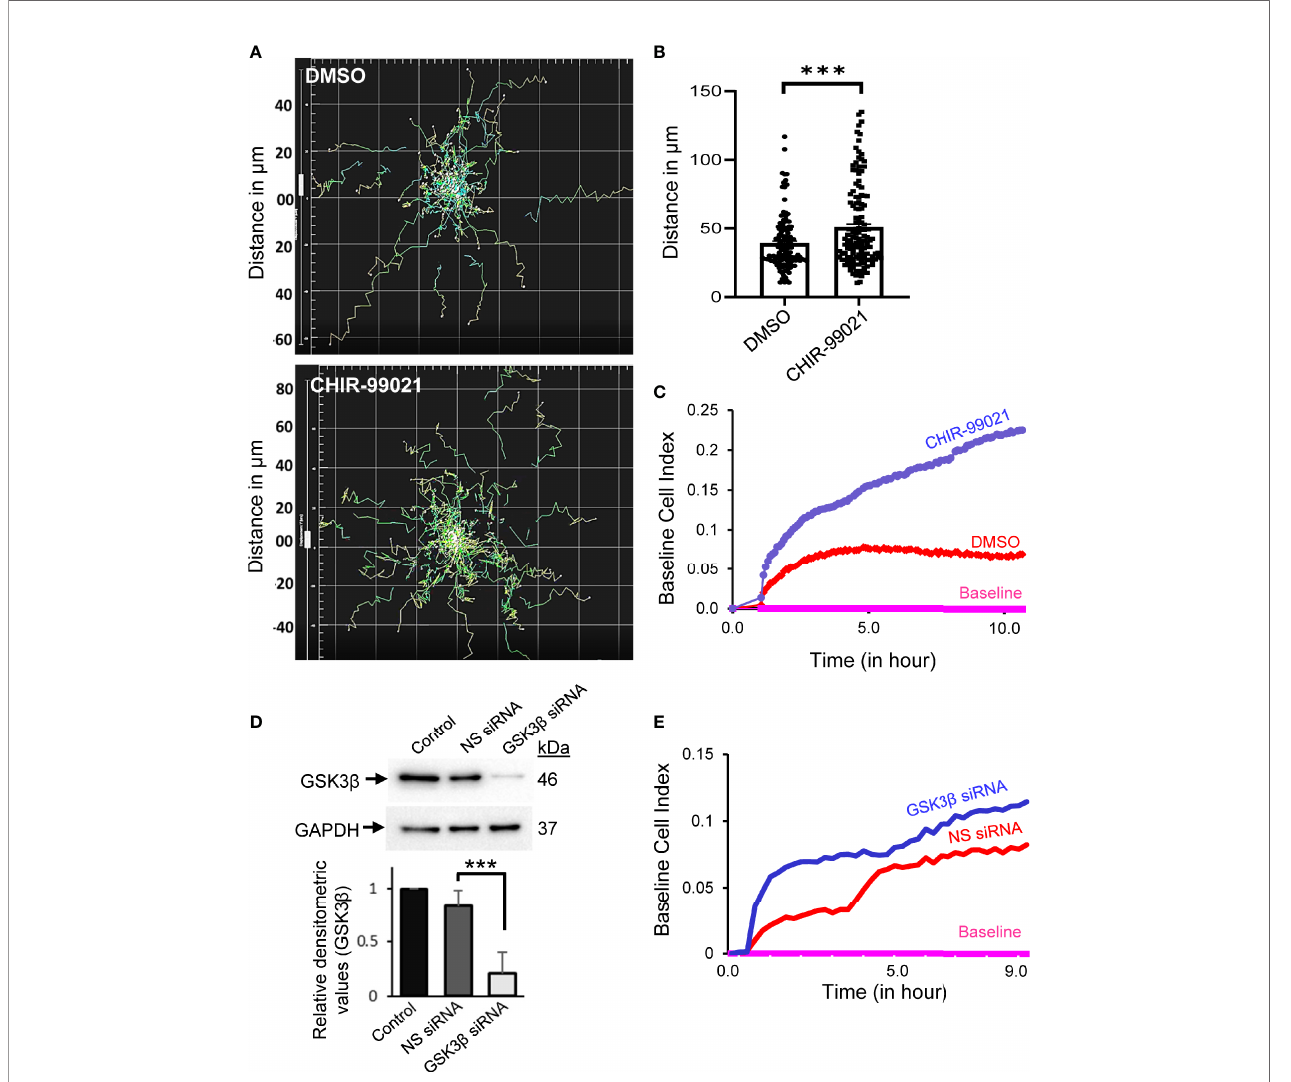
FIGURE 1 | Inhibition or depletion of GSK3 b enhances T-cell motility. (A) Human primary T-cells were pre-treated with 5 µM CHIR-99021 for 2 h to inhibit GSK3 b or DMSO (solvent control). Cells were then allowed to migrate on rICAM-1-coated plate and tracked in live cell microscopy. Spider plots showing the traced tracks of cells are presented. (B) Distance travelled by migrating T-cells over a 2-h period in m m. (C) Transwell chemotaxis of primary T-cells towards the chemokine SDF-1 a , as determined using CIM-Plate 16 and real-time impedance-based measurements by the RTCA instrument. (D) HuT78 T-cells were nucleofected with 100 nM siRNA targeting GSK3 b or non-speci fi c ( NS ) siRNA. After 72 h, cells were lysed and the expression levels of GSK3 b was determined by Western immunoblotting. Blots were re-probed for GAPDH as a loading control. The relative densitometry values for GSK3 b were determined and plotted (mean ± SEM). (E) Transwell chemotaxis of control ( NS siRNA ) and GSK3 b -depleted ( GSK3 b siRNA ) HuT78 T-cells towards SDF-1 a was determined using CIM-Plate 16 and real-time impedance-based measurements. Baseline was drawn automatically for wells without SDF-1 a . Data represent at least three independent experiments. ***p <